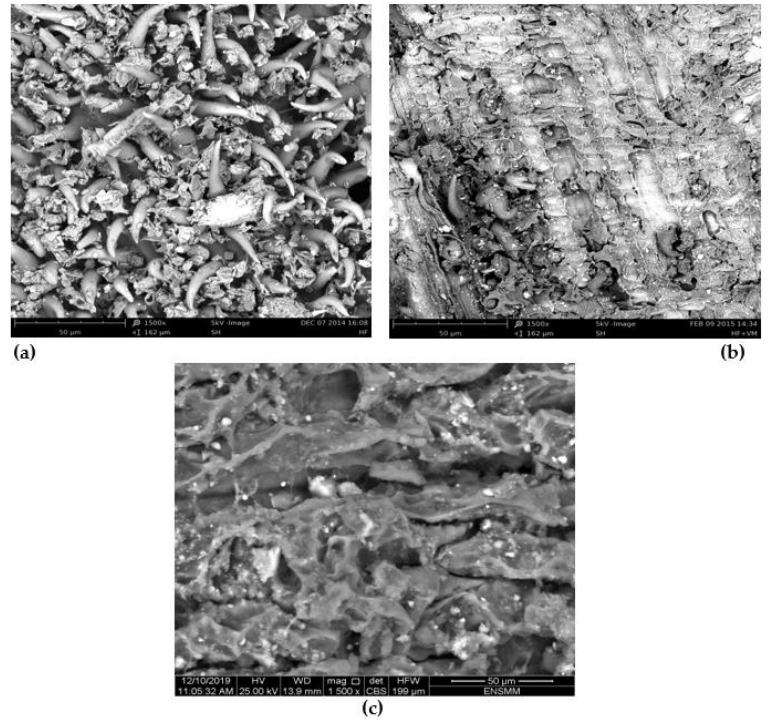
Figure 2. SEM micrograph (×1500) of ALP before ( a ) and after ( b ) MG and ( c ) CV biosorption. Table 2. Concentration of acidic and basic groups on ALP surface.